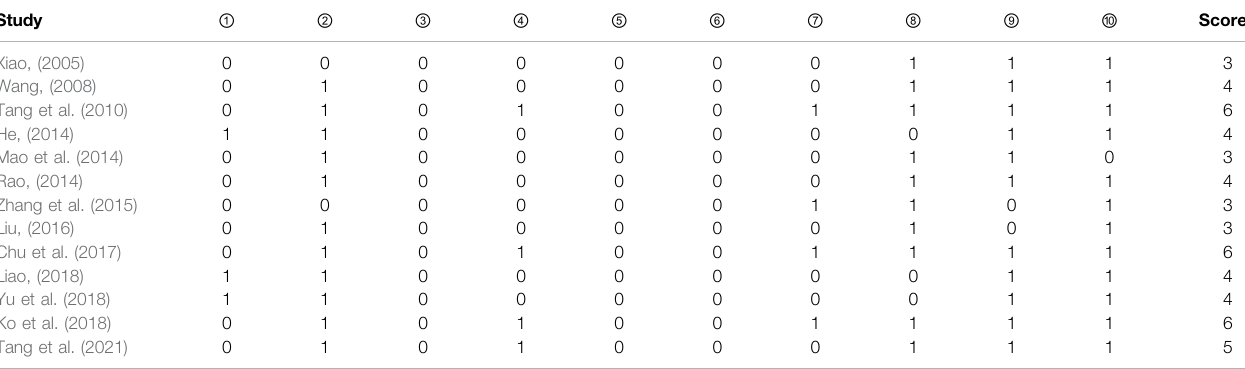
TABLE 2 | The research quality of the included